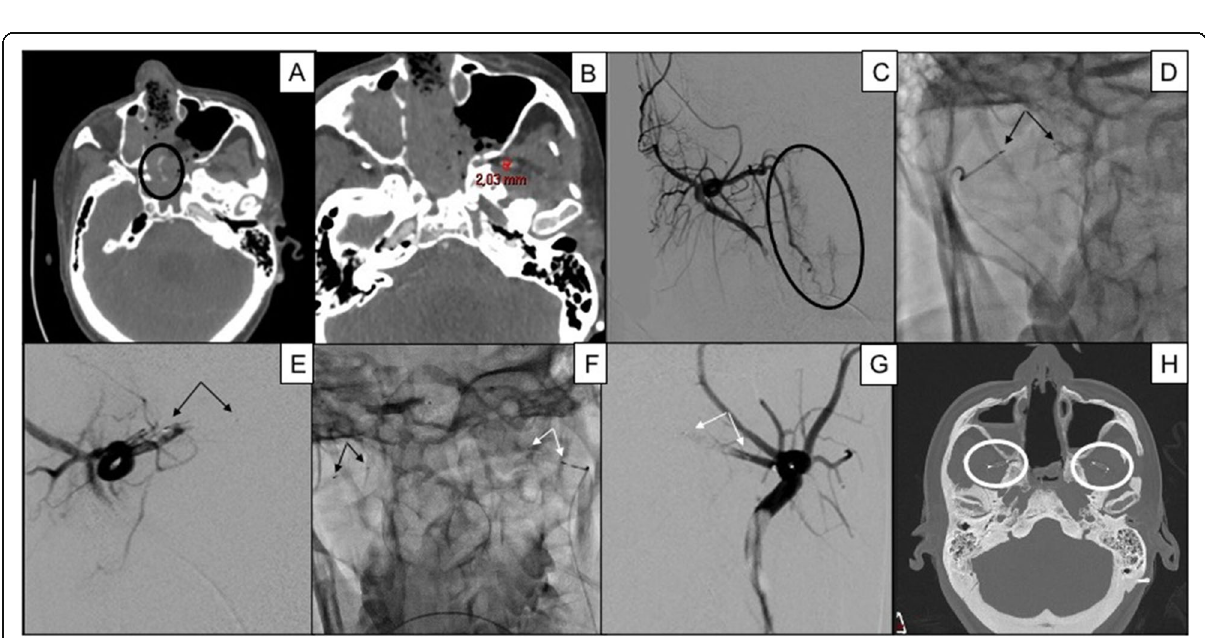
Fig. 4 37 years old male affected by bleeding nasopharyngeal carcinoma after radiotherapy; bilateral internal maxillary artery embolization was performed, first with 300 – 500 microparticles and then, because of continuous bleeding, two MVP-5. In A , a contrast-enhanced CT scan in arterial phase shows active bleeding (black circle); in B , the target vessel internal maxillary artery is measured with caliper 2.03 mm, embolization being performed bilaterally; in C , right internal maxillary DSA confirms active bleeding (black circle); in D , MVP-5 is released through a 2.7 Fr microcatheter into the distal segment of the right internal maxillary artery, black arrows indicating distal and proximal radiopaque markers: in E , DSA confirms proper right internal maxillary artery occlusion immediately after MVP release; in F , a second MVP-5 (white arrows) is similarly positioned into the left internal maxillary artery (black arrows indicating MVP-5 previously released); in G , DSA confirms proper left internal maxillary artery occlusion immediately after MVP release; in H , an axial CT scan of the skull shows the two MVP-5 (white circle) not creating any metallic